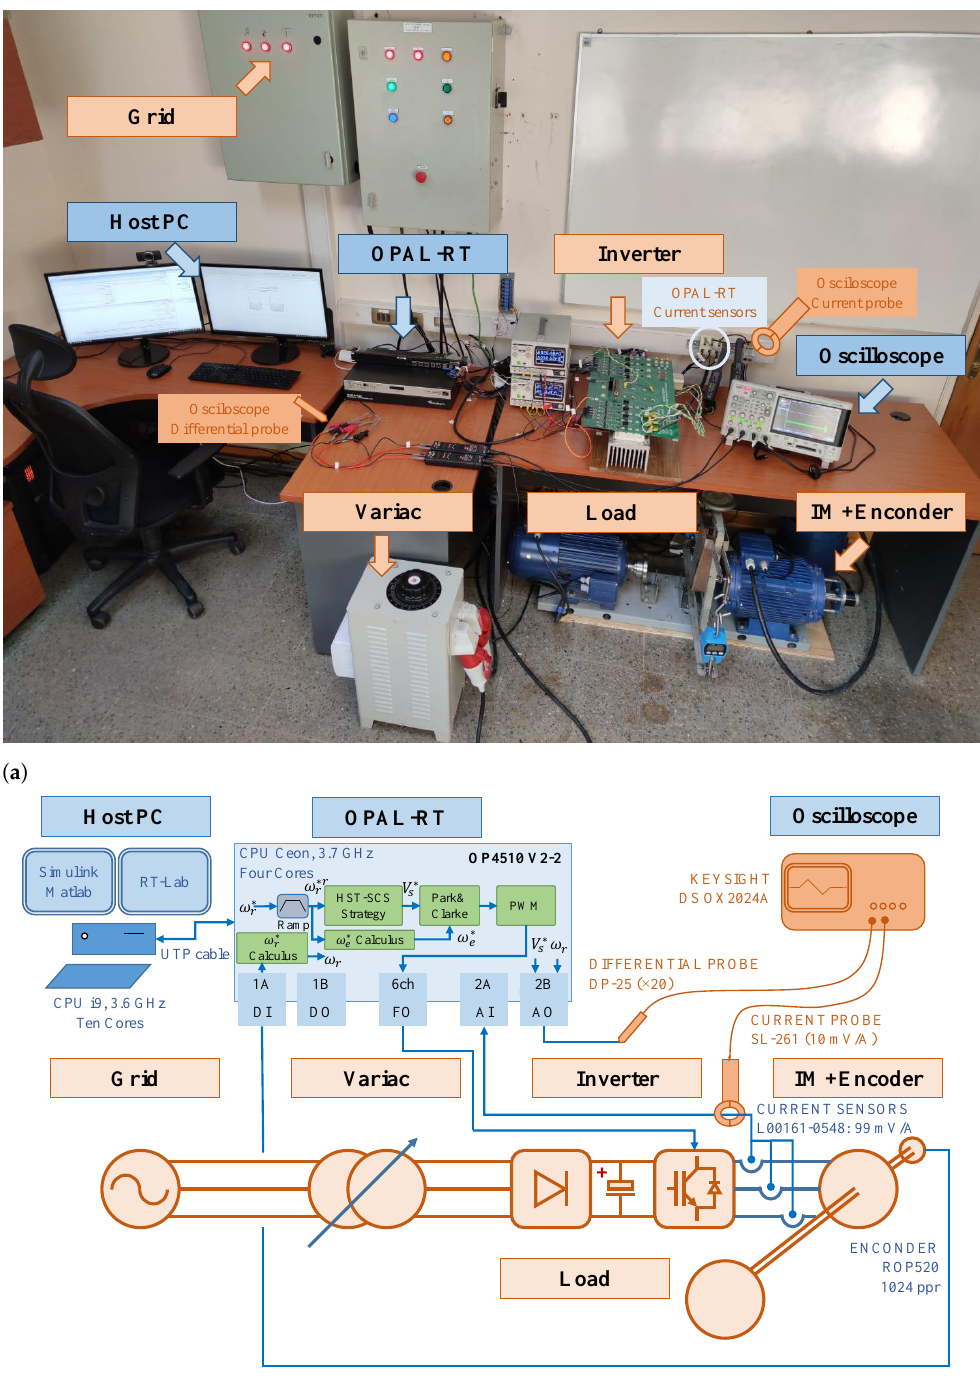
Figure 3. Test bench configuring. ( a ) Mirror-flipped picture of the test bench. ( b ) Block diagram of the test